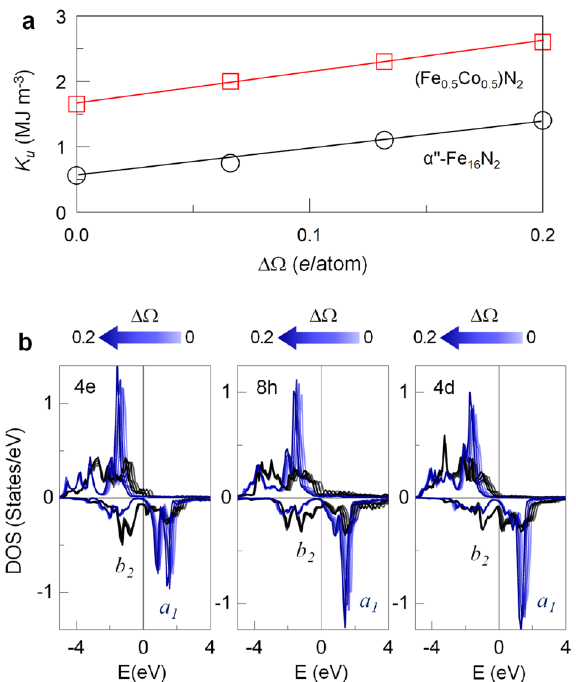
Figure 5. ( a ) Predicted K u of Fe 16 N 2 (circle) and (Fe 0.5 Co 0.5 ) 16 N 2 (square) as a function of the number of excess valence electrons, (cid:31)(cid:30) , in a unit cell. ( b ) (cid:31)(cid:30) -dependent DOS of the a 1 (blue) and b 2 (black) orbitals of Fe(4e), Fe(8h), and Fe(4d) of Fe 16 N 2 . The color-scale from light to dark in the DOS corresponds to the enhancement of (cid:31)(cid:30) from 0 to 0.2 e /atom. The Fermi level is set to